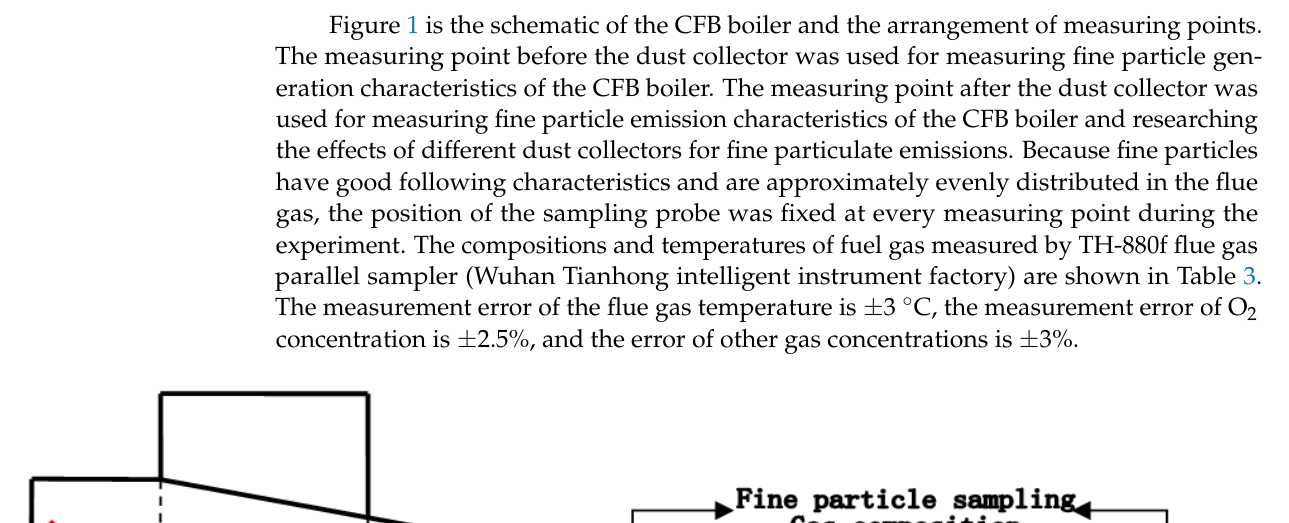
Figure 1 is the schematic of the CFB boiler and the arrangement of measuring points.